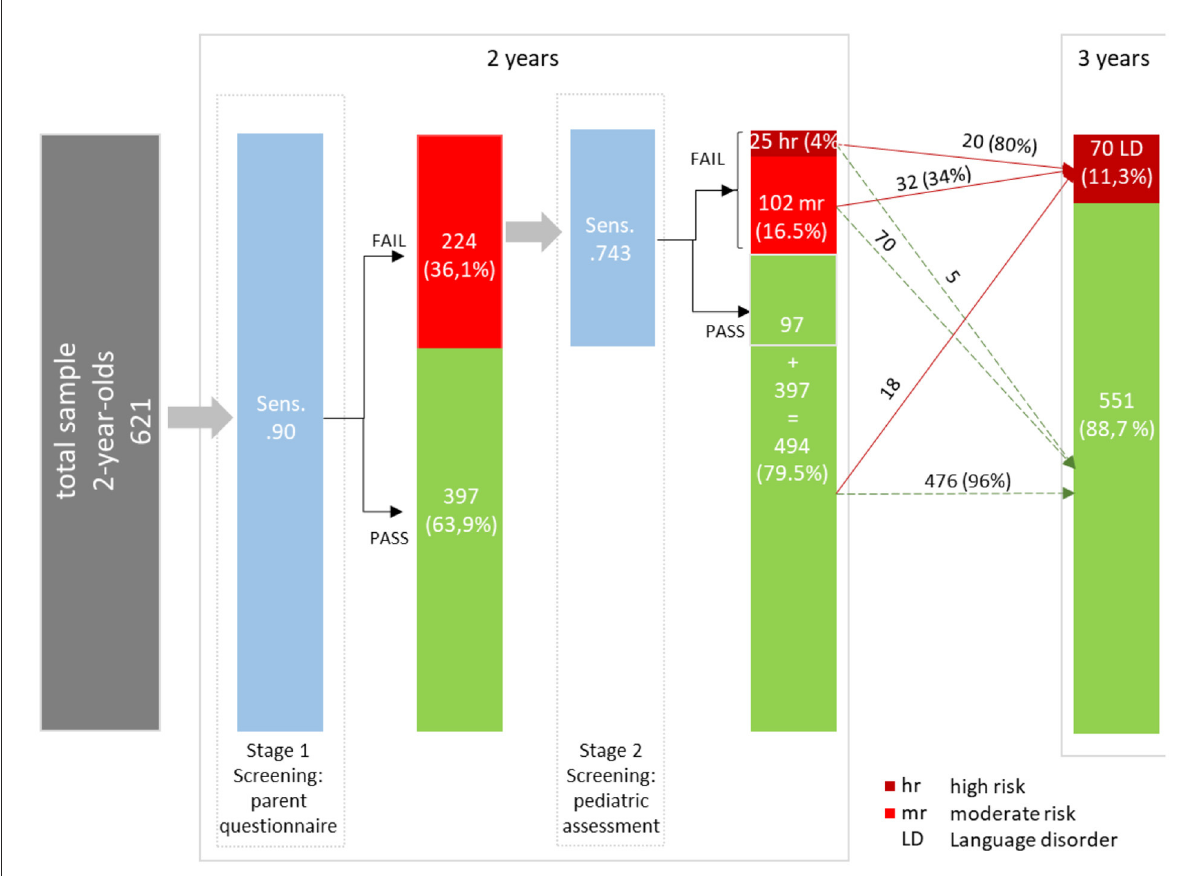
FIGURE2 Overview of results of the two-stage screening